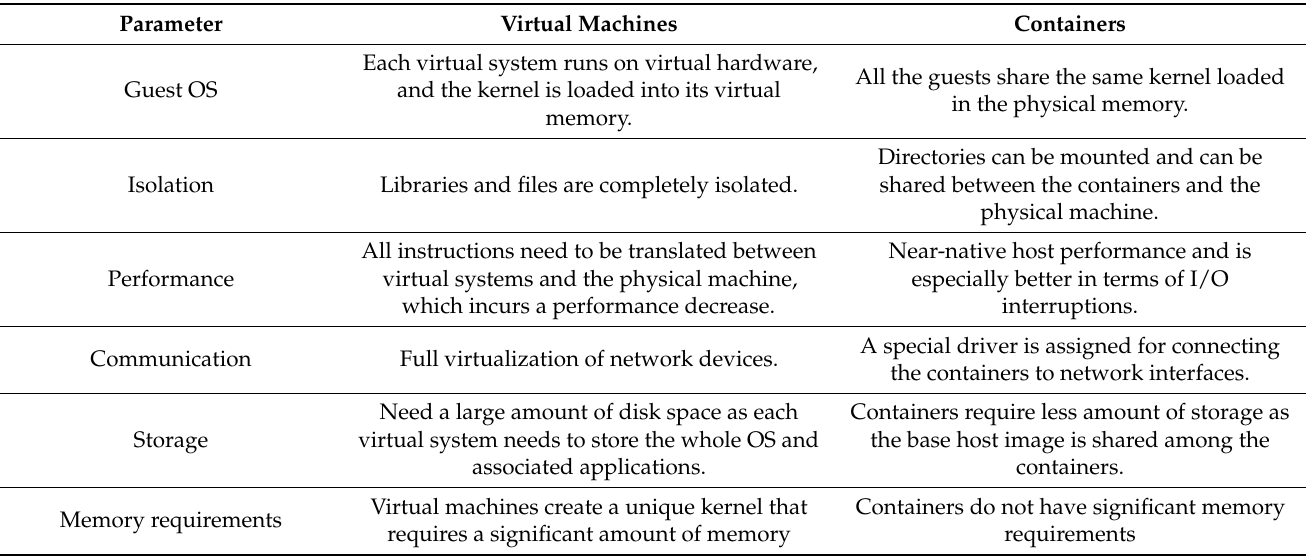
Table 1. Summary matrix for benefits and drawbacks for virtual machines and containers.